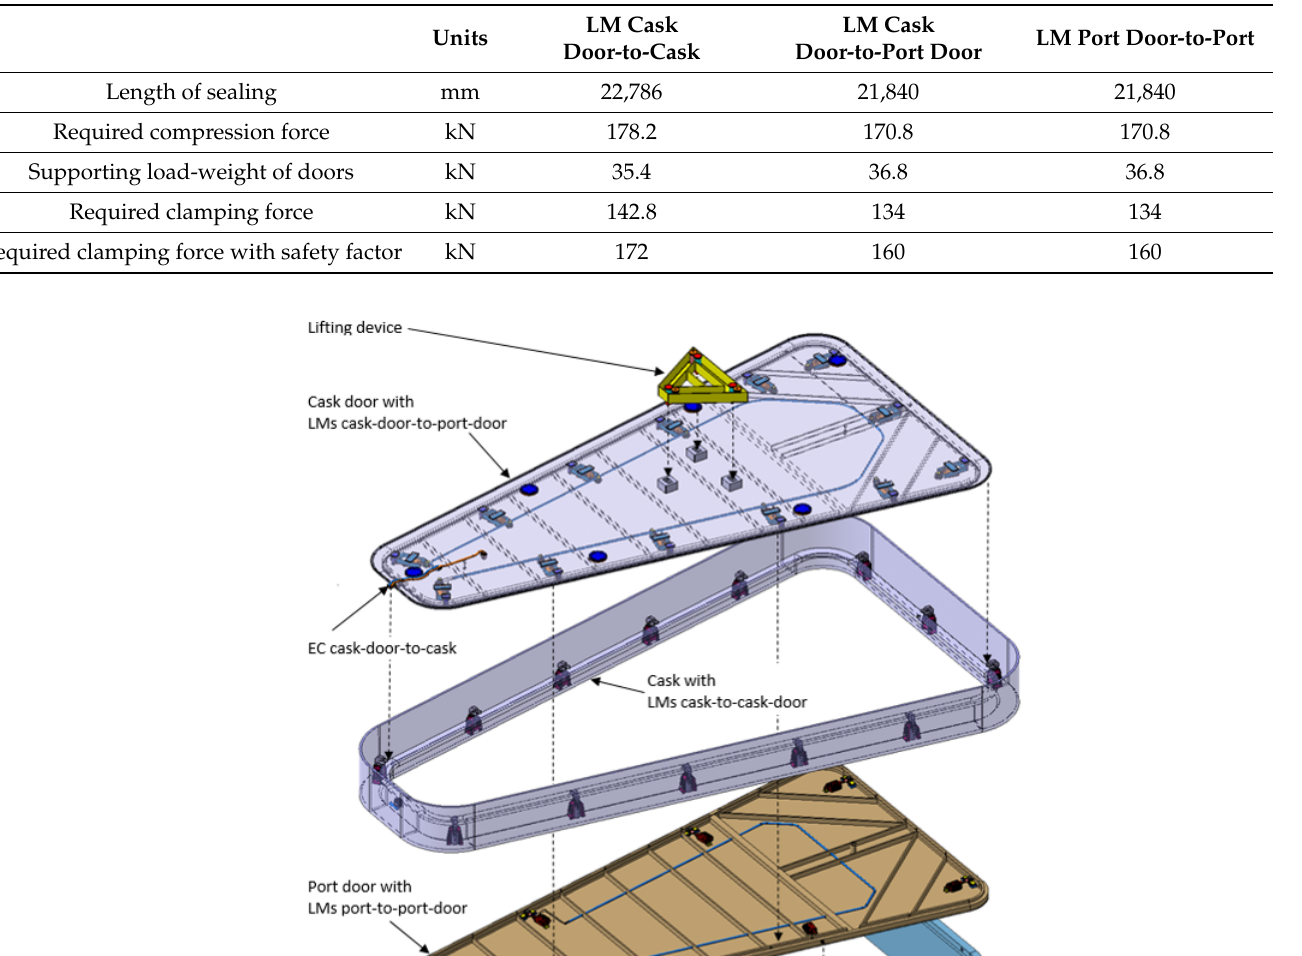
Table 1. The calculation of clamping forces.